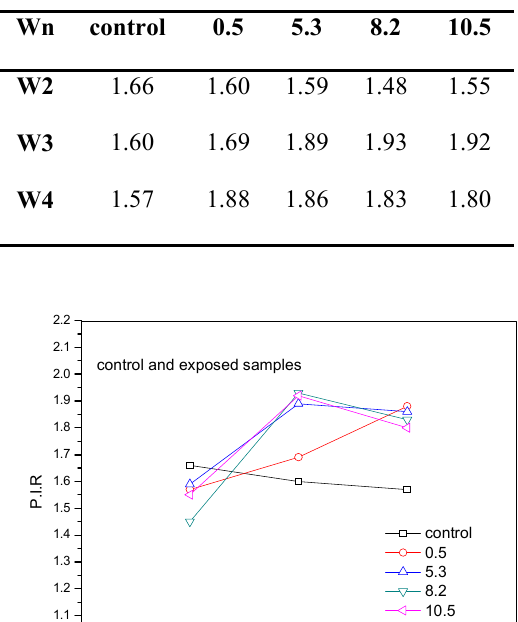
Figure 2. P.I.R vs time for the control group of Green mint. Linear fitting of data shows straight line with negative slope. Table 2: P.I.R of control/exposed groups of Green Mint.